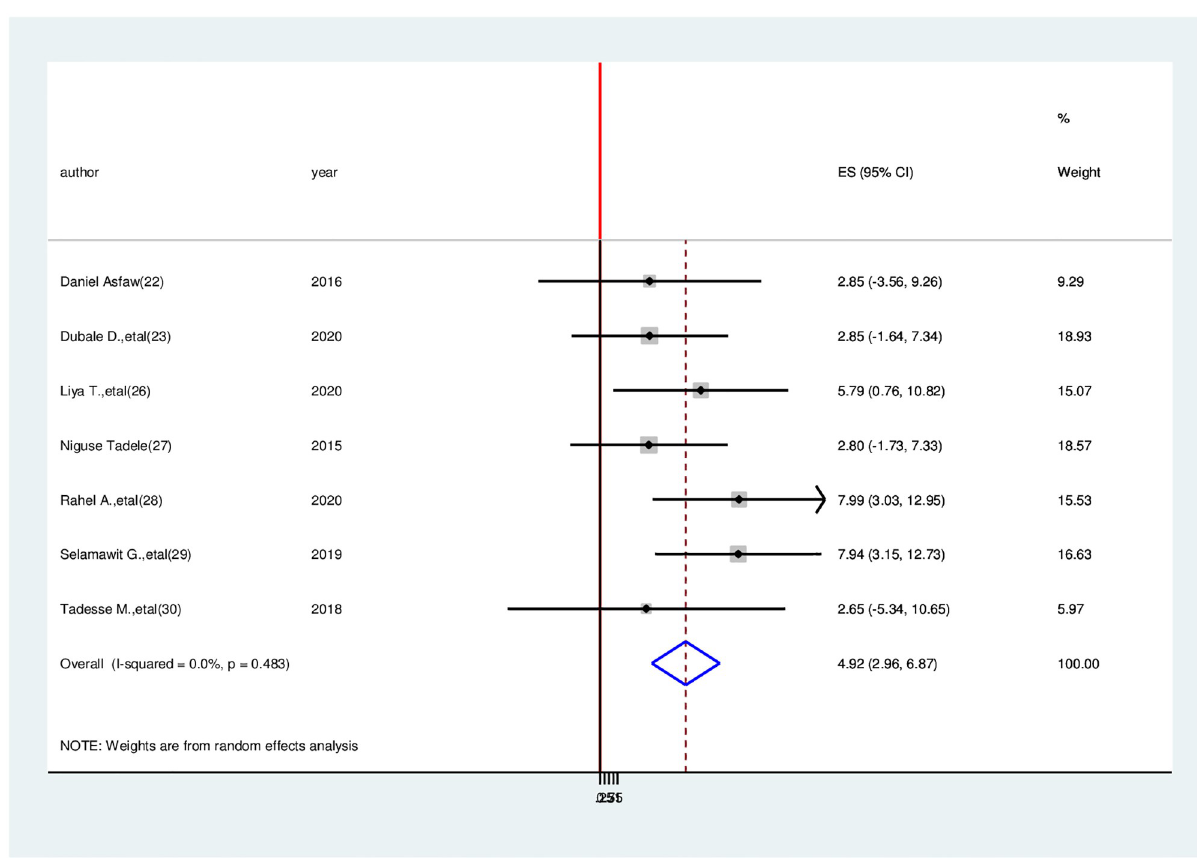
Fig 9. Association between stage of cancer and health-related quality of life among cancer patients in Ethiopia.